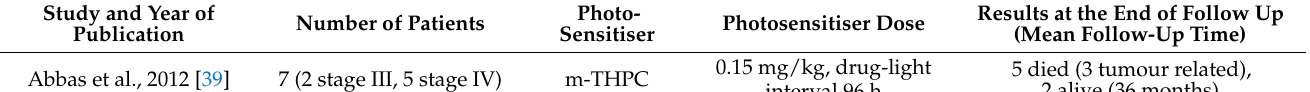
Table 1. Summary of recent clinical trials investigating the use of Photodynamic therapy(PDT) in nasopharyngeal carci- noma